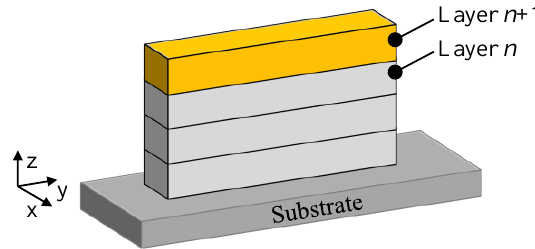
Figure 1. Schematic representation of a manufactured wall.